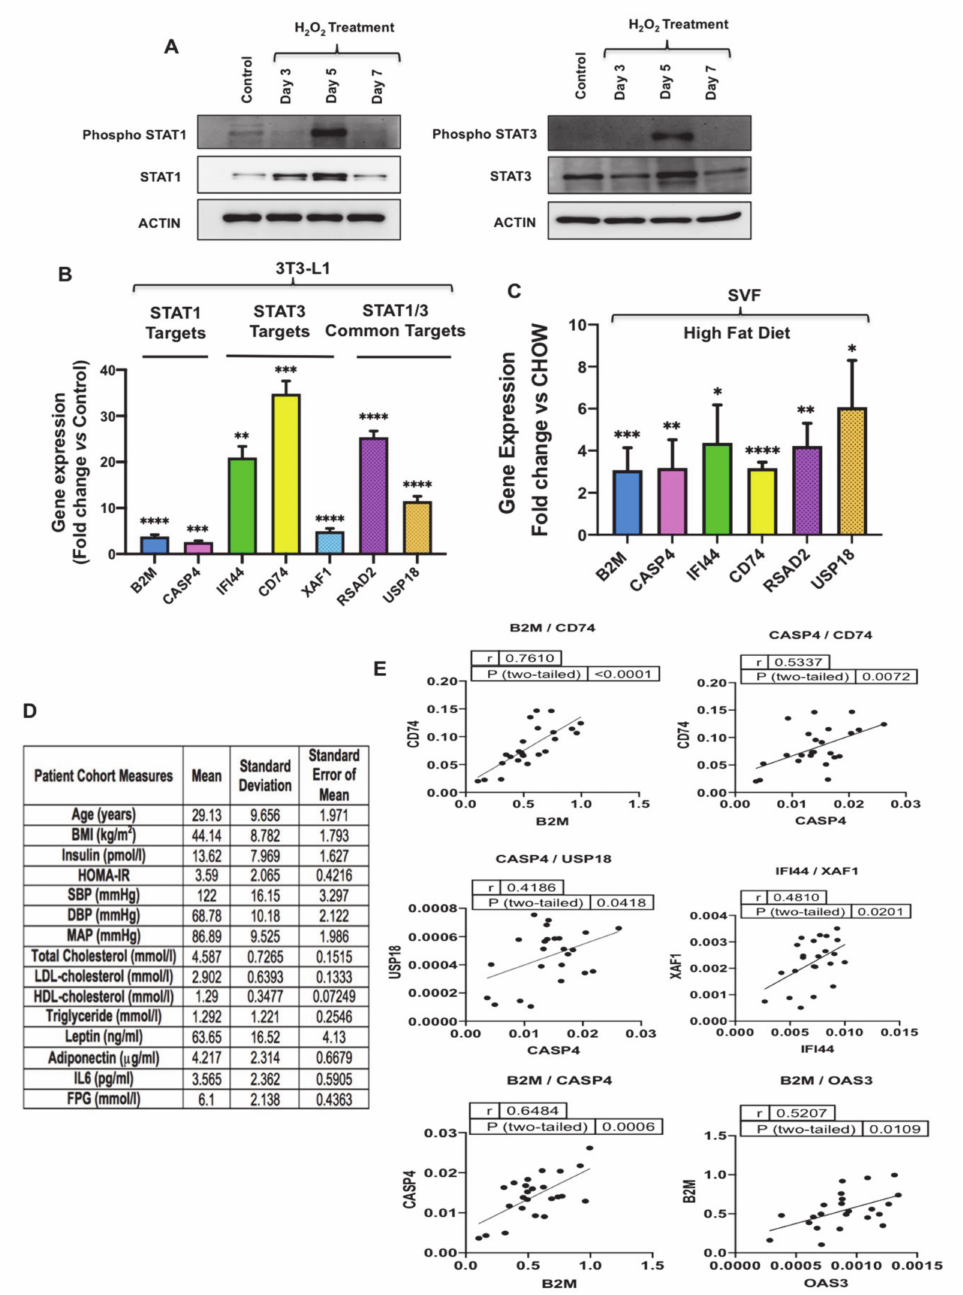
Figure 5. STAT1 and STAT3 activation in senescent preadipocytes and gene expression validation of their targets in senescent 3T3-L1, stromal vascular fraction (SVF) and human adipose fat tissues. ( A ) Western blot analysis of phospho-STAT1 (Y701), STAT1, phospho-STAT3 (Y705), STAT3 in proliferating and H 2 O 2 treated preadipocytes at different time points. Actin was used as a loading control. ( B ) Gene expression analysis of the most significantly upregulated STAT1/3 targets in senescent preadipocytes by real-time qPCR. Results (fold change vs. control) are presented as means ± SEM from three independent experiments. ** p ≤ 0.01, *** p ≤ 0.001, **** p ≤ 0.0001 (Student’s t-test). ( C ) Gene expression analysis of STAT1/3 targets in SVF of high-fat diet mice by real-time qPCR. Gene expression results (fold change) are presented as means ± SEM from three independent experiments. * p ≤ 0.05, ** p ≤ 0.01, *** p ≤ 0.001, **** p ≤ 0.0001 (Student’s t-test). ( D ) Table of patient cohort measures selected for the study. Body Mass Index (BMI), Homeostatic Model Assessment for Insulin Resistance (HOMA-IR), Systolic Blood Pressure (SBP), Diastolic Blood Pressure (DBP), Mean Arterial Pressure (MAP), Low Density Lipoprotein (LDL), High-Density Lipoprotein (HDL). ( E ) Correlation analysis of STAT1/3 targets gene expression data in human adipose